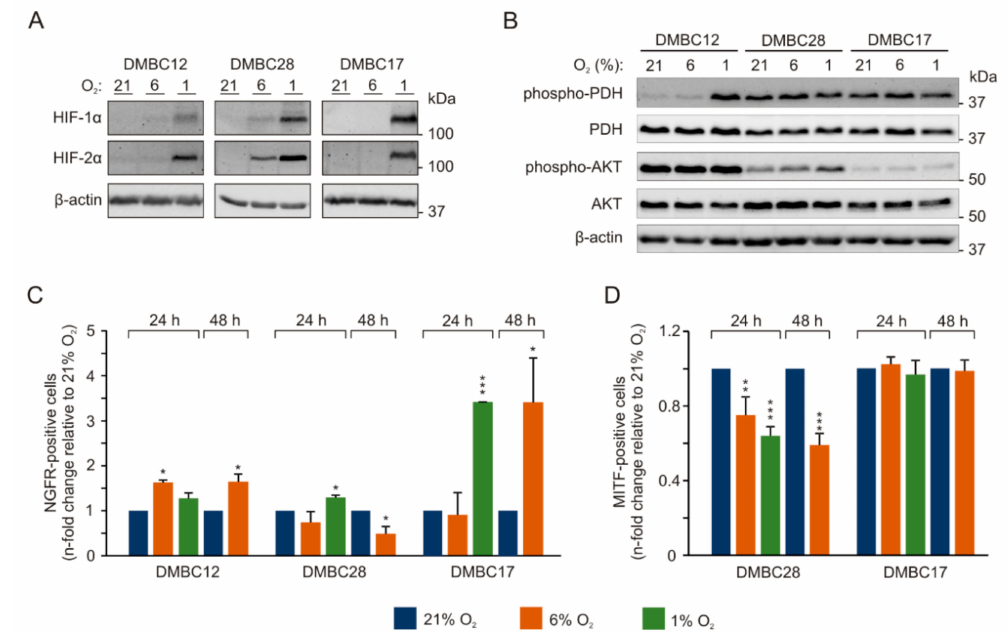
Figure 2. Phenotypic alterations in melanoma cells in di ff erent oxygen concentrations depend on initial phenotype of melanoma cells. Melanoma cells were incubated at di ff erent oxygen concentrations, 21% O 2 (hyperoxia) 6% O 2 (normoxia) and 1% O 2 (hypoxia). Protein levels of ( A ) HIF